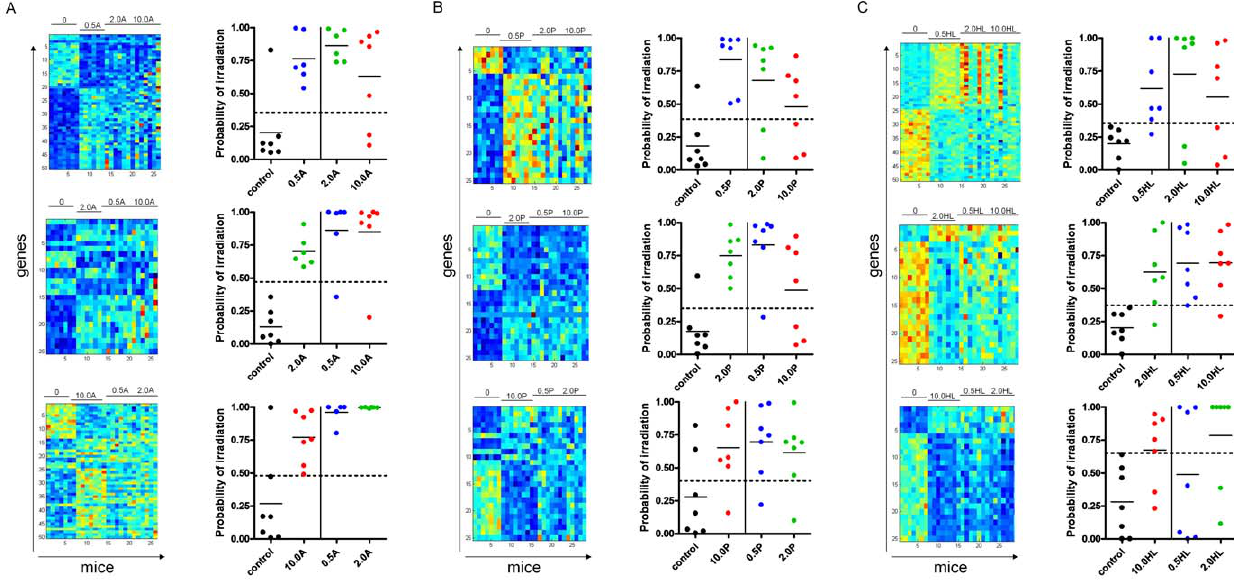
Figure 1. Gene expression profiles that reflect partial body irradiation. At left, gene expression patterns in the peripheral blood of mice are shown which were selected for predicting irradiation of (A) anterior hemibody (AH), (B) posterior hemibody (PH) irradiation, and (C) hind limb (HL) irradiation versus no irradiation at 0.5 Gy (top), 2 Gy (middle) and 10 Gy exposure (bottom). Each column represents a sample from an individual experiment, and each row represents a gene. High expression is depicted as red and low expression is depicted as blue and the range of expression is 0.06 to 210. At right, leave one-out-cross validation analyses of the classification probabilities using the binary regression model (see Methods) of control vs. 0.5 Gy, control vs. 2 Gy, and control vs. 10 Gy are shown. Each dot represents a PB sample from an individual mouse. These analyses demonstrate that the signatures of (A) AH irradiation for 0.5 Gy, 2 Gy and 10 Gy were highly accurate at predicting the status of AH-irradiated from non-irradiated mice (92%, 100% and 93% accuracy for 0.5, 2, and 10 Gy, respectively), but demonstrated less accuracy in distinguishing dose levels. (B) The signatures of PH irradiation were highly accurate at predicting radiation status versus control mice but showed less accuracy at distinguishing radiation dose levels. (C) The signatures of HL irradiation were highly accurate at predicting radiation status versus control mice but showed less accuracy at distinguishing radiation dose levels.